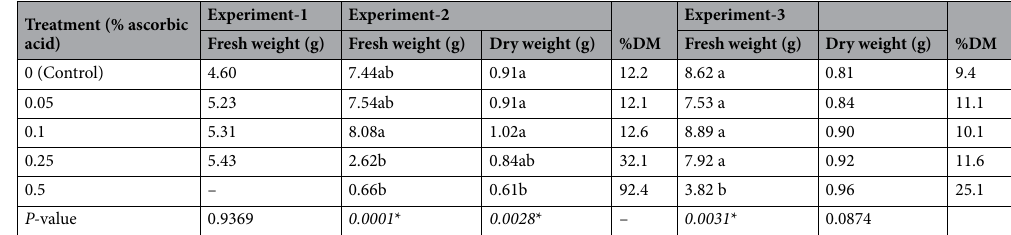
Table 2. Fresh weight and dry weight of microgreens treated with application of different concentrations of ascorbic acid in 3 experiments. Significant values are in italics. DM dry matter. *Significant differences ( p ≤ 0.05) among treatments are indicated by different lowercase letters within the